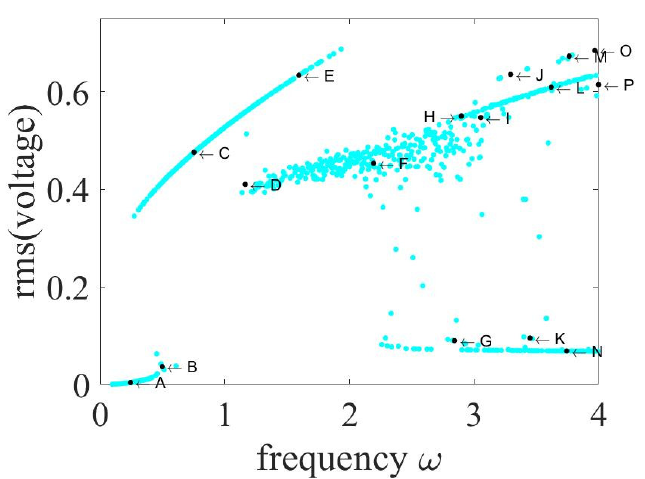
Figure 2. Bifurcation diagram for voltage output. Note that, in the simulations, the initial position was fixed inside one of the potential wells ( x 0 = 1) while the initial velocity was set as a random number selected from the interval [ − 1.5, 1.5], different for each ω .